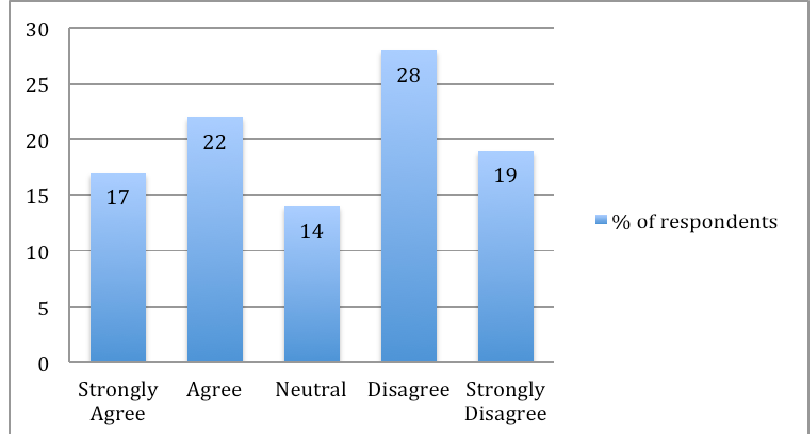
Figure 9. Lack of interest in creating and/or using